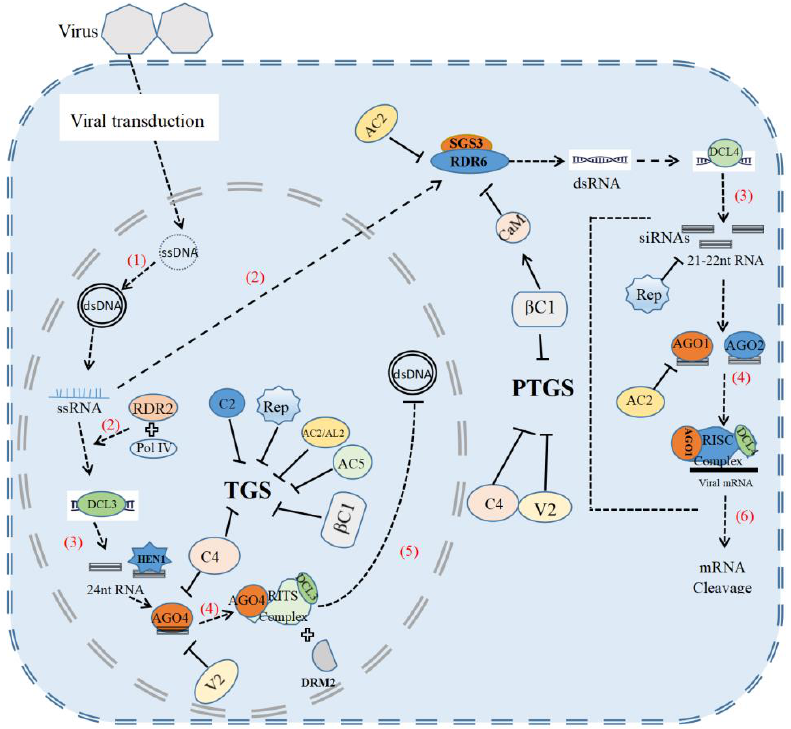
Figure 1. Antiviral RNA silencing and viral suppressors. (1) In the nucleus, viral ssDNA is converted to dsDNA. (2) The virus then uses host RDR2 or RDR6 to convert ssRNA to dsRNA. (3) dsRNA is processed into 21-22 or 24 nt siRNAs mediated by Dicer (DCL) where, in the nucleus, the 24 nt siRNAs are stabilized by HEN1. (4) Argonaute 4 (AGO4) and AGO1/2 interact with siRNA to form the RNA-induced transcriptional silencing complex (RITS) and RNA-induced silencing complex (RISC), respectively. (5) In the nucleus, RITS targets the viral transcribed genome and then interacts with structural domain-rearrangement methyltransferase 2 (DRM2) to achieve transcriptional gene silencing (TGS) of the viral genome. (6) In the cytoplasm, RISC mediates post-transcriptional gene silencing (PTGS), which inhibits the transcription of viral genes by degrading viral mRNA. In order to successfully infect, viruses produce several viral suppressors (VSRs). For example, in the nucleus, β C1, AC2, C2, C4, Rep, AC5 can interact with key components of the TGS pathway to help the virus resist transcriptional gene silencing. C4 and V2 promote viral infection by interacting with AGO4. In the cytoplasm, the viral β C1, C4, Rep and V2 proteins can similarly have a role in inhibiting post-transcriptional gene silencing and promoting viral infection. In addition, the viral AC2 protein can interact with host AGO1 and RDR6 to inhibit RNA silencing, and rgsCaM can inhibit post- transcriptional gene silencing by inhibiting the binding of RDR6 to SGS3. In addition, the β C1 protein of the virus can stimulate the accumulation of the rgsCaM protein to a certain